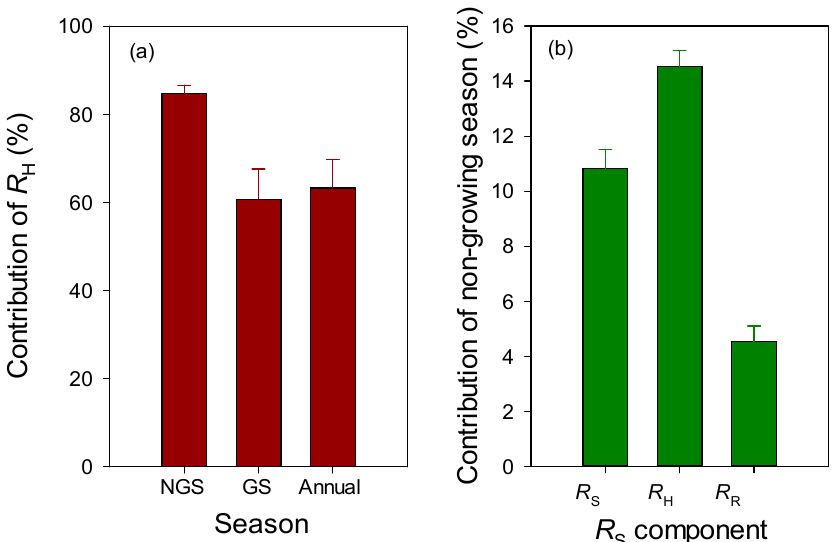
Figure 4. Contributions of the non-growing season to annual (climatic year) respiration for soil ( R S ), heterotrophic ( R H ), and rhizospheric ( R R ) respirations ( a ); the contribution of R H to R S for the non-growing season (NGS; from November to April), the growing season (GS; from May to October) and annual fluxes ( b ). The error bars are standard deviations of the three plots.